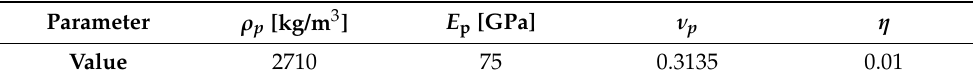
Table 2. Material properties of the plate in the